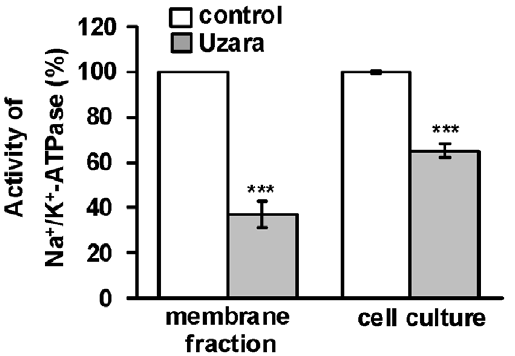
Figure 3. Inhibitory effect of Uzara on the Na + /K + -ATPase enzymatic activity in membrane preparations from HT-29/B6 cells. In cell culture experiments, monolayers were treated with 50 m m g/ml Uzara for 90 min. Then, cells were homogenized and a crude membrane fraction was prepared. Herein, the Na + /K + -ATPase activity was measured (n=5). In a further set of experiments, membrane fractions of untreated HT-29/B6 cell monolayers were prepared and subsequently treated with 50 m g/ml Uzara which was added for 1 h to the enzyme activity assay (n=8). Both conditions revealed a direct inhibitory activity on the ion pump. Values are expressed as percentage of control activity. Basal activity of the Na + /K + -ATPase was between 36 and 73 nmol P i /(min ? mg protein). Data are expressed as mean 6 s.e.m. Asterisks indicate difference versus control: ***P , 0.001.